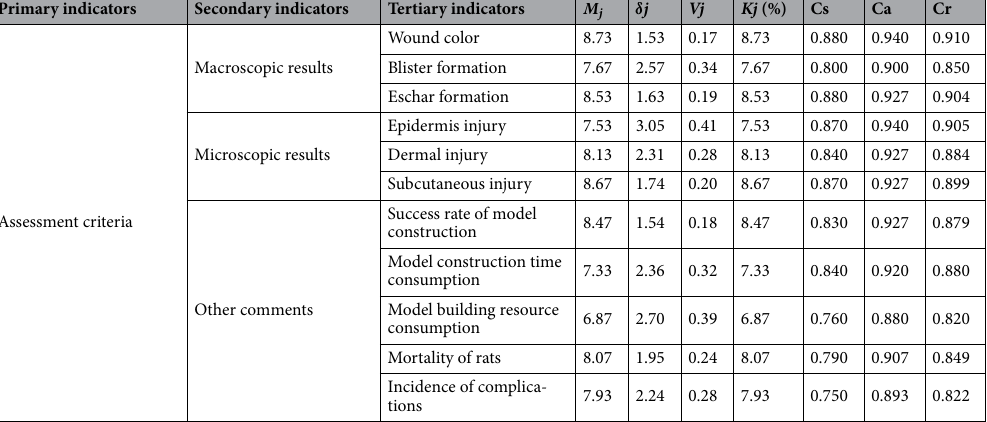
Table 4. The first round of index system based on Delphi method. M j , means; δ j , standard deviation; Vj , coefficient of variation; Kj , full score frequency; Ca, judgment coefficient; Cs, familiarity coefficient; Cr, expert authority coefficient.